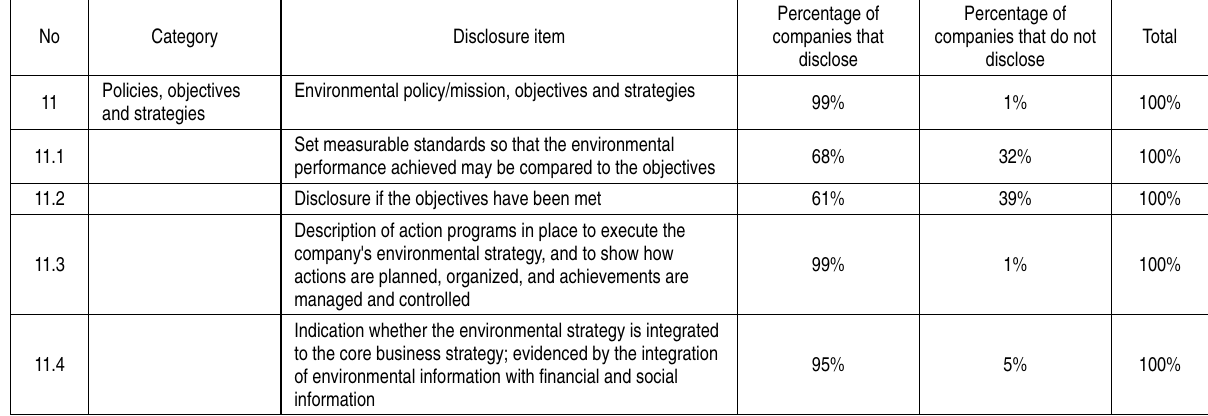
Table 6. Disclosure of environmental policies, objectives and